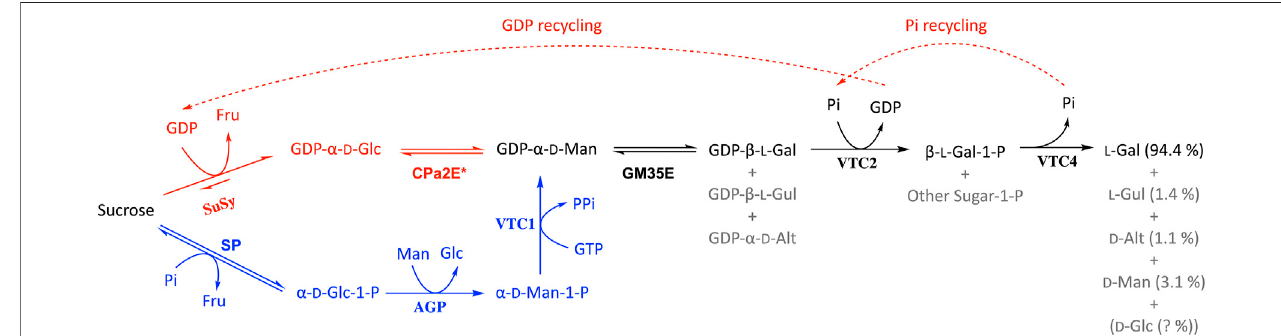
FIGURE 6 | Biocatalytic pathway for the production of L -Gal starting from GDP-Man (as described in (Gevaert, 2020)) in which the GM35E plays a crucial role (black). Thetheoreticaloptionstostart L -Gal synthesis from sucrose aregivenin red and blue (explanation inmain text). SuSy,sucrose synthase;CPa2E, CDP-paratose 2-epimerase; SP, sucrose phosphorylase; AGP, α - D -Glc 1-P phosphatase; VTC1, GDP-Man pyrophosphorylase; VTC2, GDP- L -Gal phosphorylase; VTC4, L -Gal-1-P phosphatase.